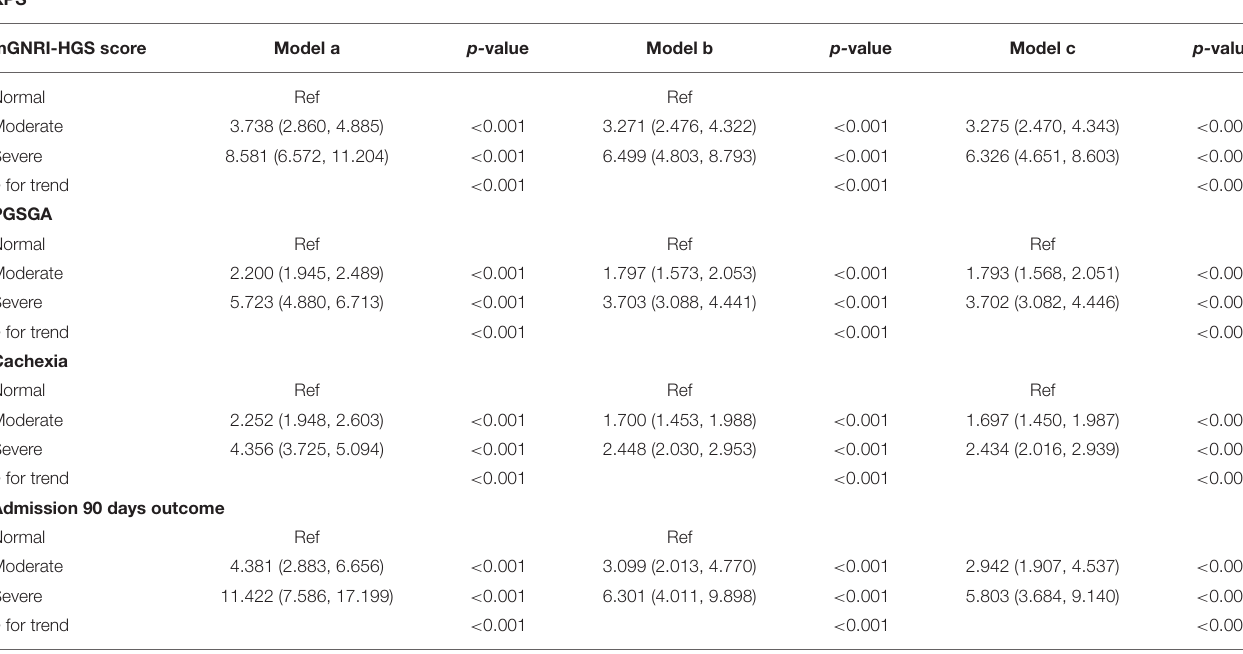
TABLE 2 | Logistic regression analysis of mGNRI-HGS score associated with secondary outcome.